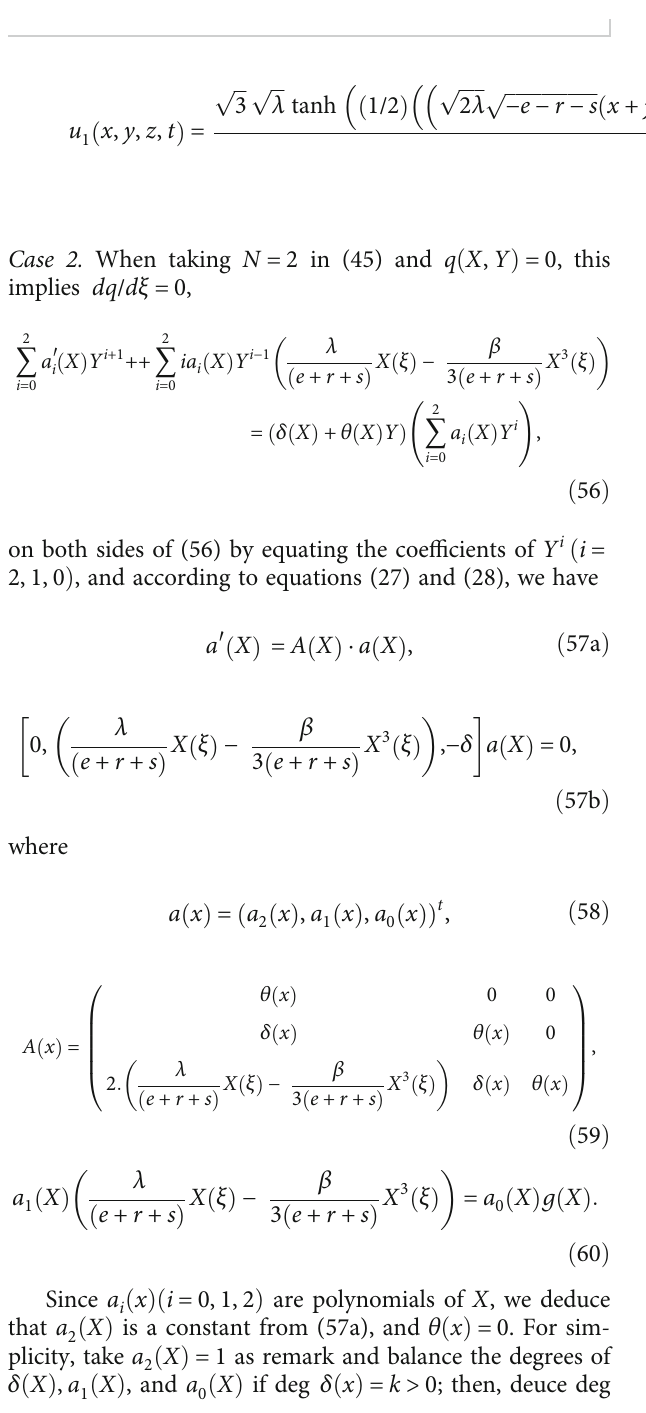
ffiffiffiffiffiffiffiffiffiffiffiffiffiffiffiffiffiffi p − e − r − s